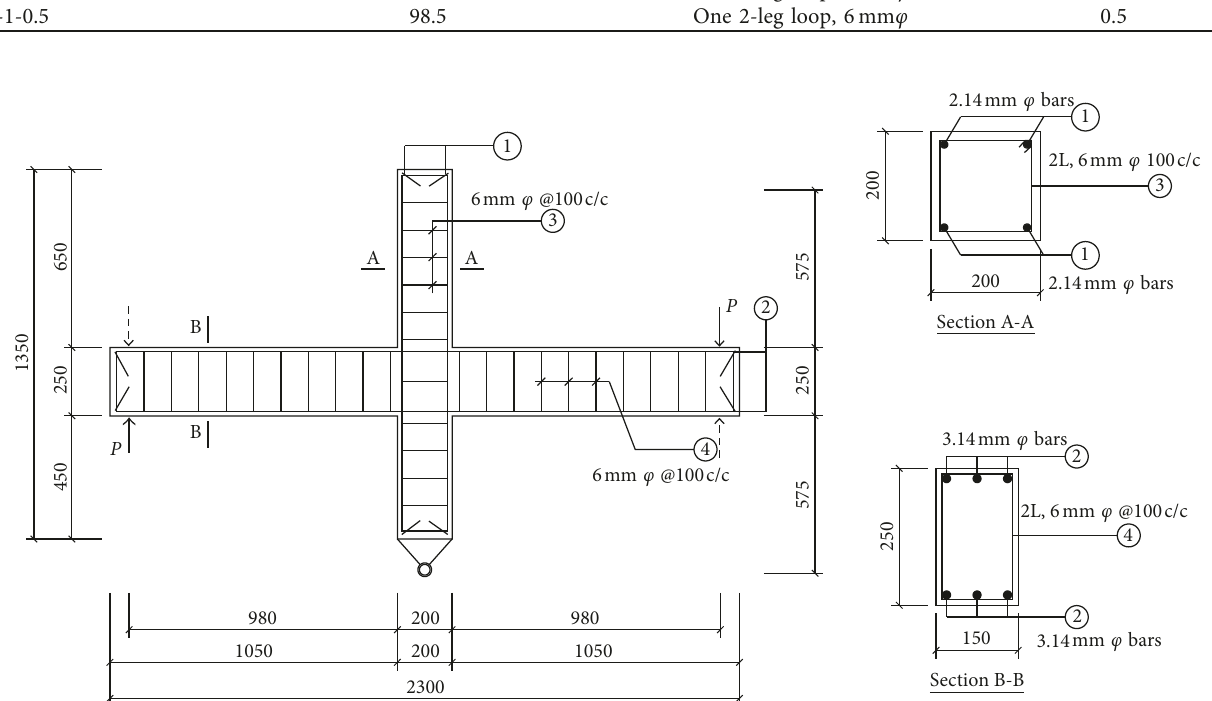
Figure 1: Details of